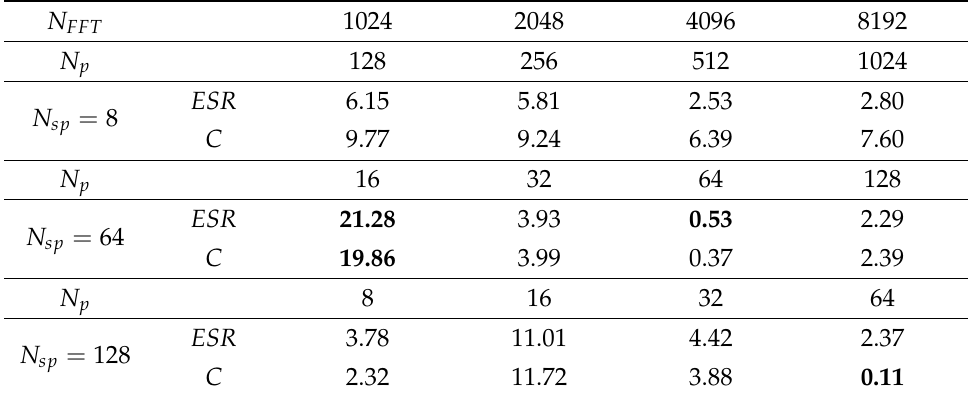
Table 9. Percentage error estimating C and ESR with A d = 10% of the nominal duty